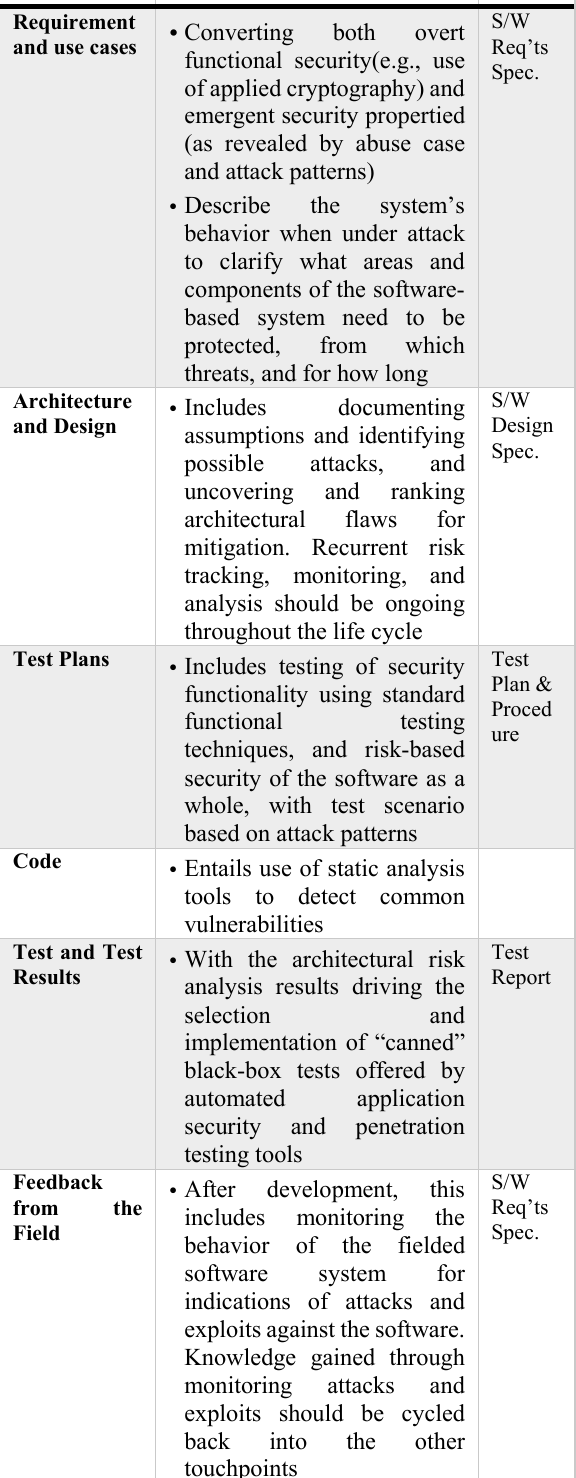
Fig. 6. Seven Touchpoints of Secure